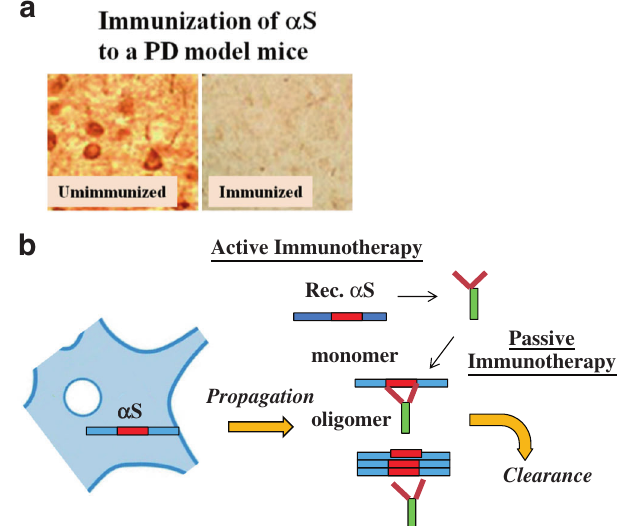
Fig. 2 Preclinical results of α S immunotherapy for PD. a Represen- tative fi gures of the α S immunohistochemistry of the transgeic mice brains with ( right ) or without ( left ) immunization of α S. Reprinted from Masliah et al. (2005). 20 b Schematic representation of the mechanism of active and passive immunotherapies of α